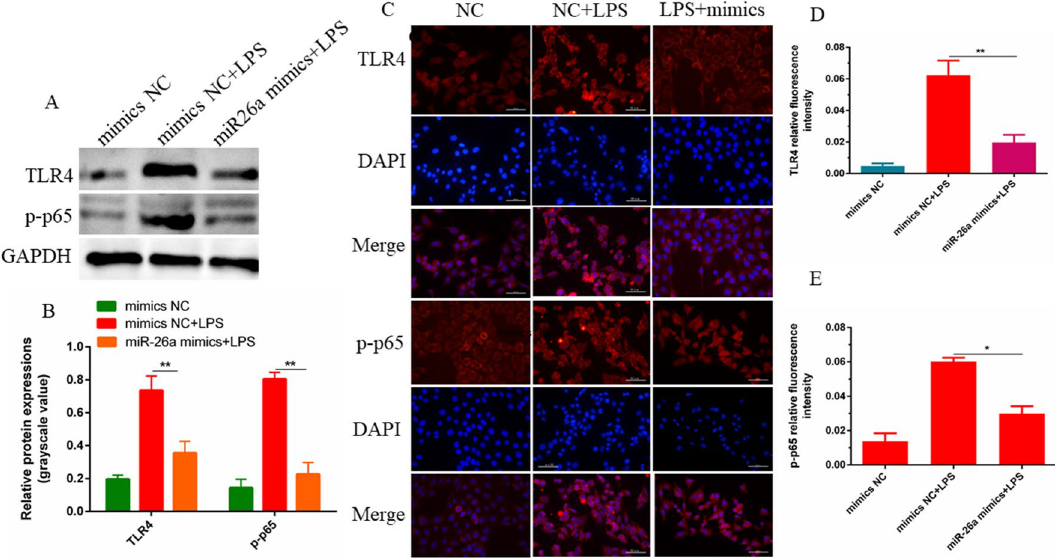
Figure 5. miR-26a negatively regulates the NF-κB pathway. ( A , B ) The miR-26a mimic and NC mimic were transfected into bEECs for 24 h. The phosphorylation level of NF-κB p65 and the expression level of TLR4 were determined by western blotting. Image-Pro Plus (IPP) 6.0 software calculated protein gray levels. GAPDH as a service reference. ( C ) Immunofluorescence (× 400) was used to assess the phosphorylation level of p65 and the expression of TLR4. ( D , E ) The IOD/area was evaluated by IPP 6.0 software, and revealed the p-p65 nuclear translocation and the fluorescence intensity of TLR4. Data are expressed as mean ± S.D., Three independent